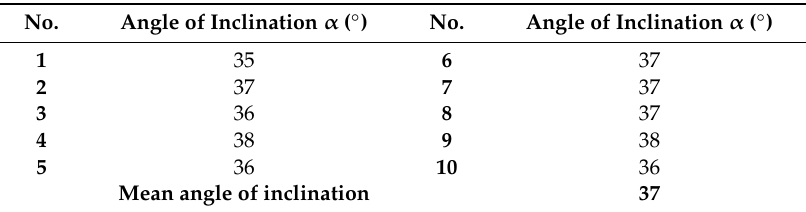
Table 6. Angles of inclination of friction cone.